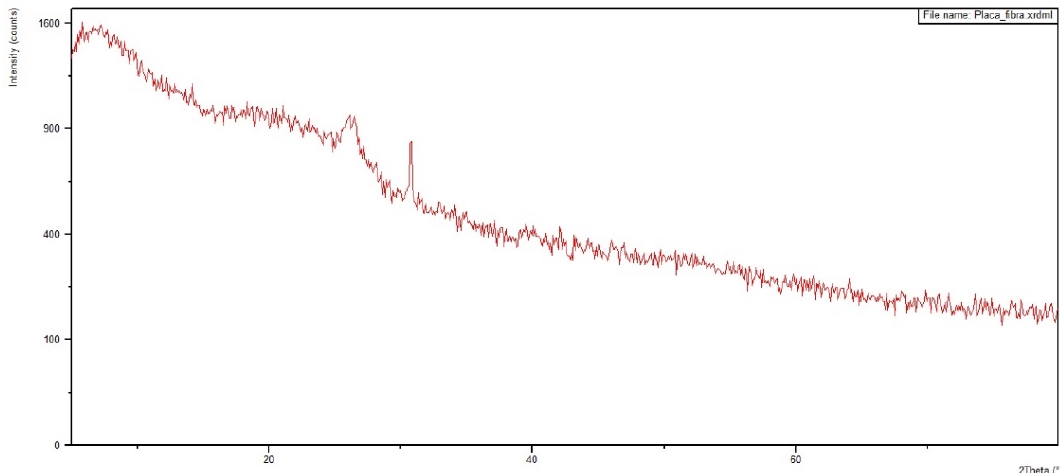
Figure 13. Diffractogram of the 30 vol% ramie fabric-reinforced GO-incorporated epoxy composite in Figure 13. Di ff ractogram of the 30 vol % ramie fabric-reinforced GO-incorporated epoxy composite in the physical state of a solid plate. the physical state of a solid